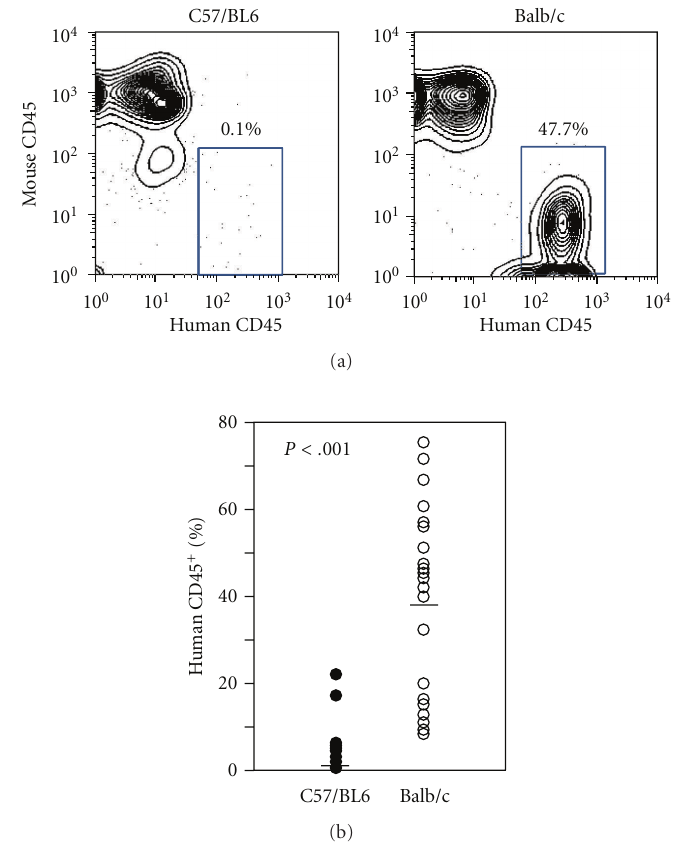
Figure 3: Balb/c Rag-2 − / − Jak3 − / − mice support human peripheral blood mononuclear cells (PBMC) engraftment more e ffi ciently than C57/BL6 Rag-2 − / − Jak3 − / − mice. PBMC (2 × 10 7 cells/mouse) were transplanted into irradiated adult mice intravenously. Peripheral blood of PBMC transplanted recipients were obtained 12 weeks after transplantation, and human and murine chimerism was assessed by flow cytometry.